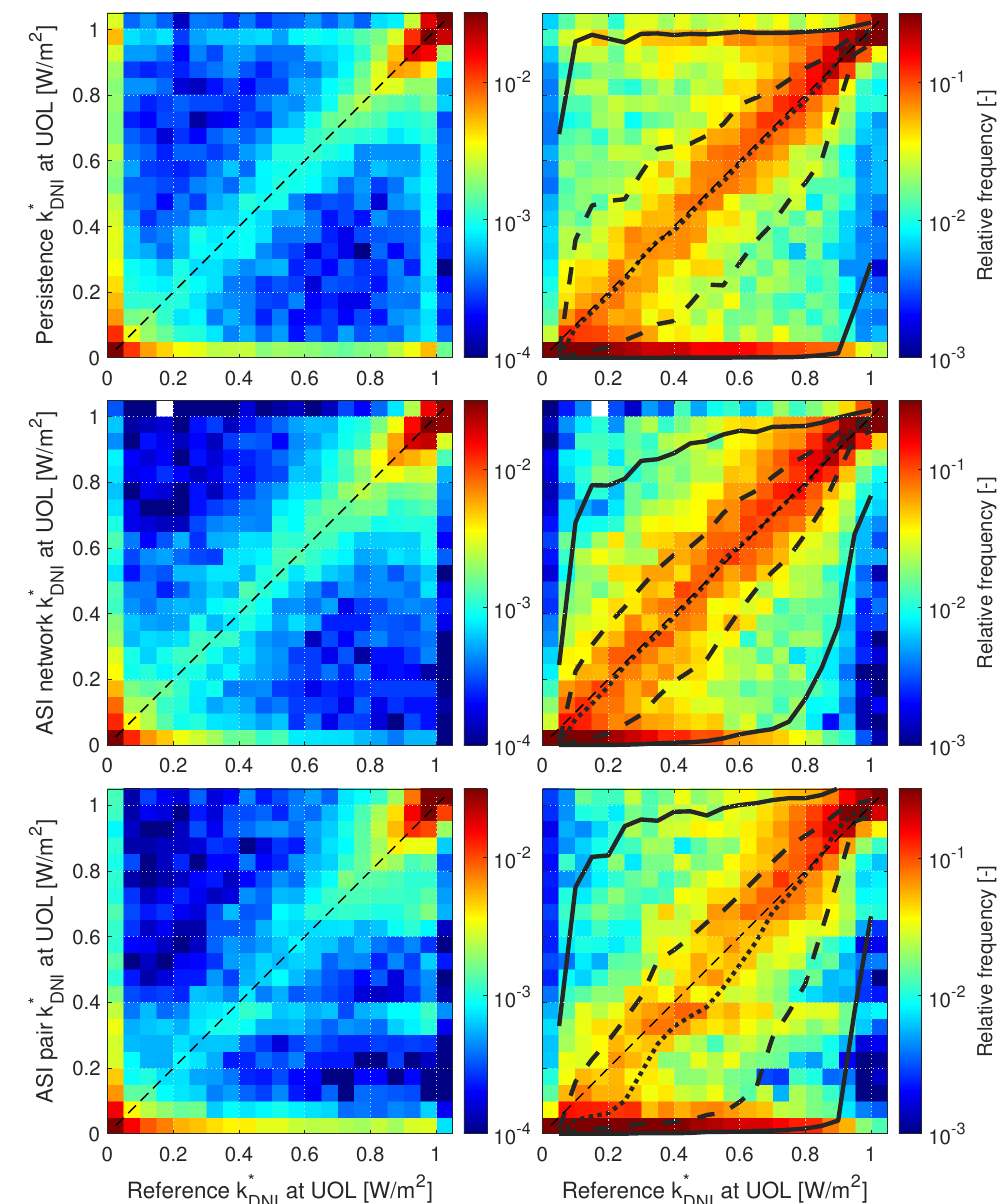
Figure 13. This figure shows relative frequencies of the DNI clear sky index ( k ∗ ) from the respective DNI analysis over the reference measurement. Homogeneous persistence ( top row ), the ASI network ( center row ) and ASI pair ( bottom row ) are evaluated. In the panels on the right-hand side, relative frequencies are normalized for each column in the plot. This means that relative frequencies add to one in each column of the respective plot. Each panel also shows 5th, 95th (solid), 25th, 75th (dashed) and 50th-percentile (dotted). The coefficient of correlation R 2 is 0.63 for homogeneous persistence ( top row ), 0.84 for the ASI network ( center row ), 0.73 for the ASI pair ( bottom row